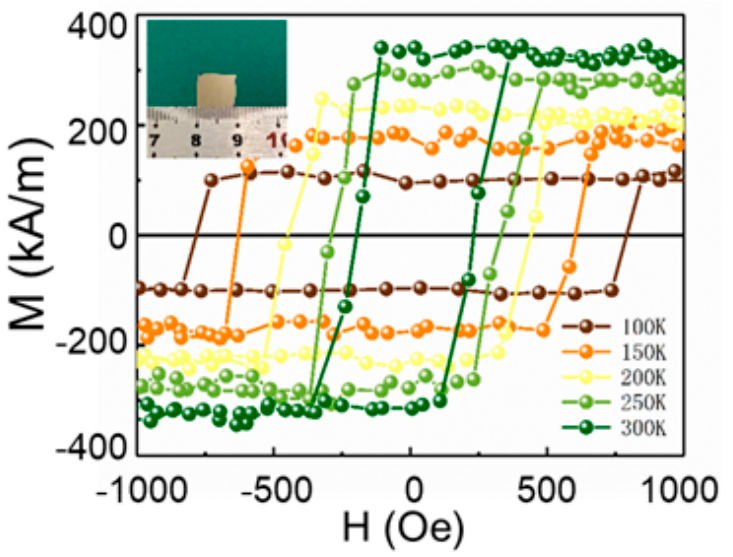
Figure 2. M-H hysteresis loops of Pt/Co/Pt heterostructure under OOP magnetic field between 100 K and 300 K. The inset is the photograph of the film.